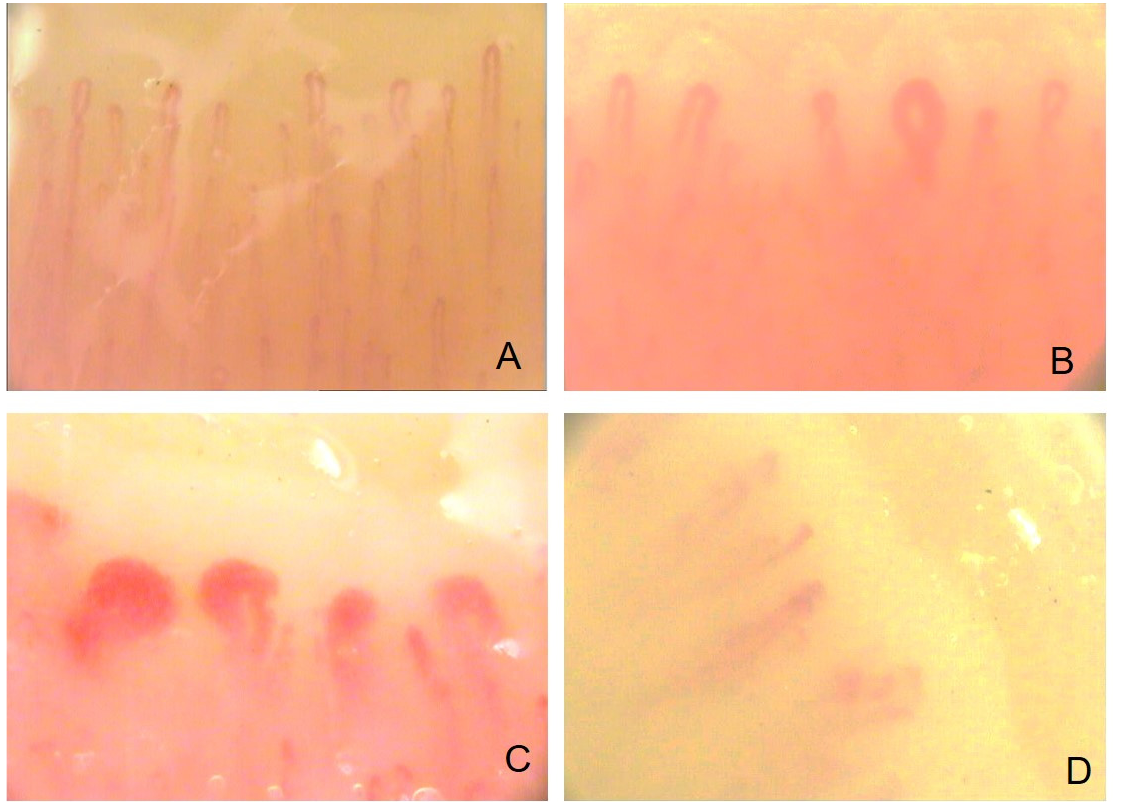
Figure 1. Nailfold videocapillaroscopy images ( × 200) in healthy subjects ( A ), “Early” ( B ), “Active” ( C ), and “Late” ( D ) patterns of scleroderma microangiopathy.